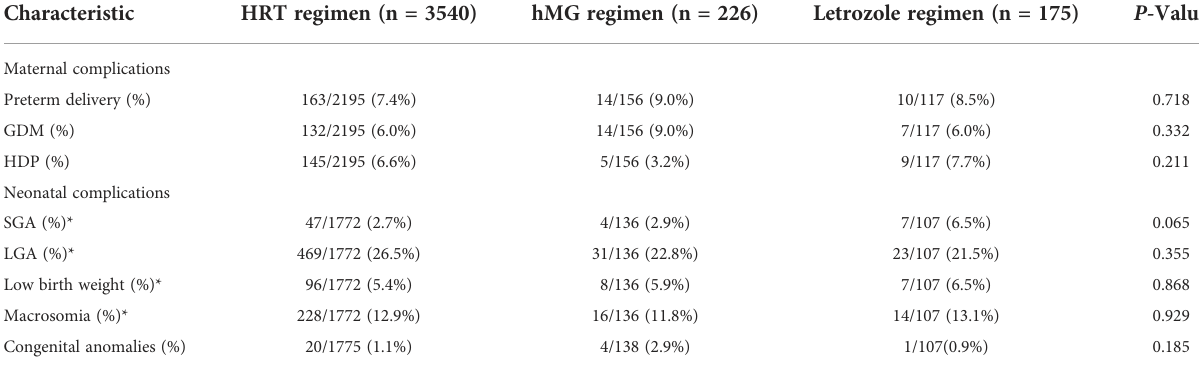
TABLE 3 Maternal and neonatal